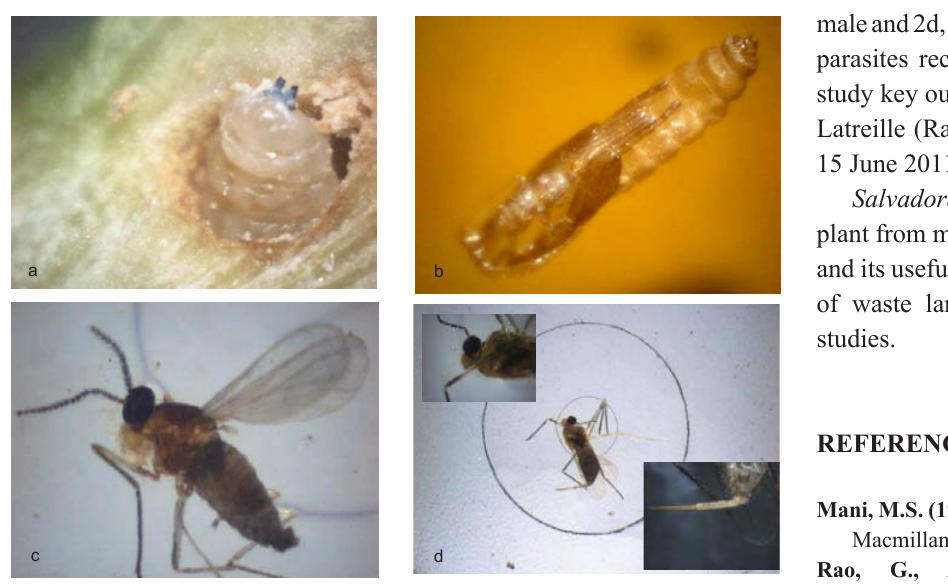
Image 2. Gall midge larva and adult. © Moawia Mohamed (a) developing gall midge larva, (b) gall midge pupa, (c) gall midge adult (male) and (d) gall midge adult